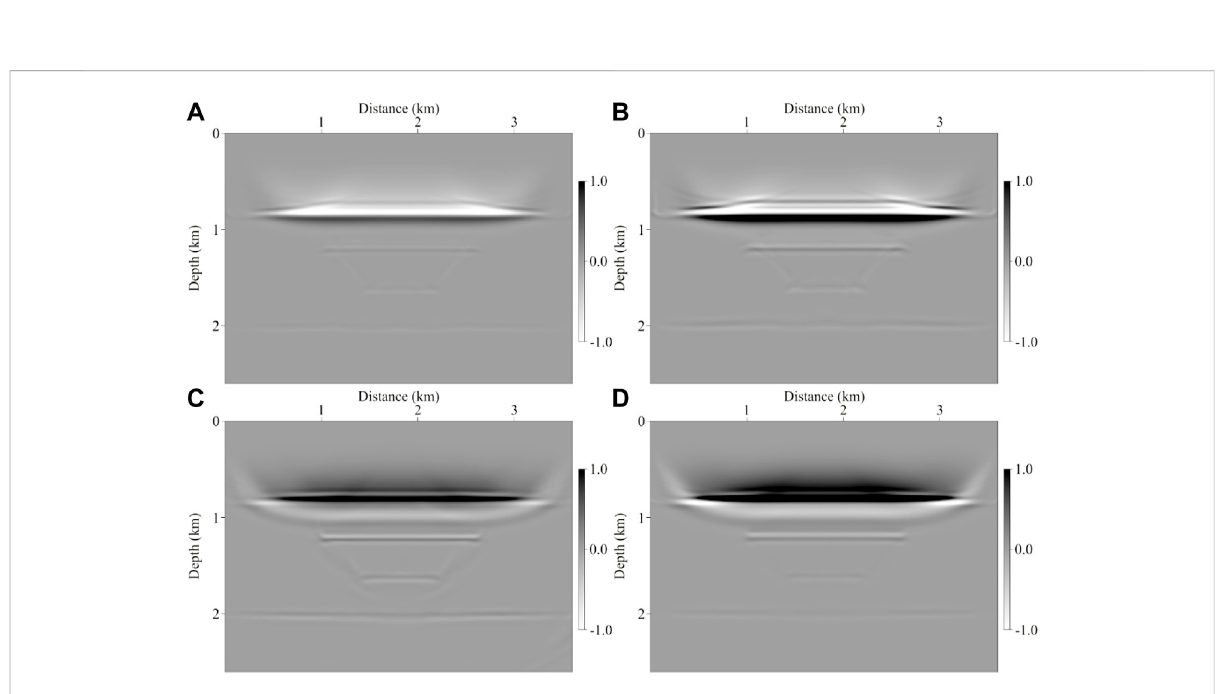
are low-frequency noise interference and unbalanced energy distribution in the imaging results of all methods. Figure 4 shows the LSRTM images based on different methods for the gas block model, which are isotropic LSRTM, viscoacoustic LSRTM, VTI LSRTM, and viscoacoustic VTI LSRTM, respectively. It can be seen that the low-frequency noise and artifacts in the pro fi le are effectively suppressed, the energy distribution is balanced, and the resolution of the image is improved. Compared with the imaging results in Figure 3, it can be found that the viscoacoustic VTI LSRTM approximates